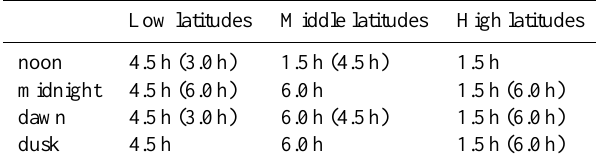
Table 2. The MLDT of the storm-time density changes in respect to E m at different local time sectors for high, middle and low latitudes.